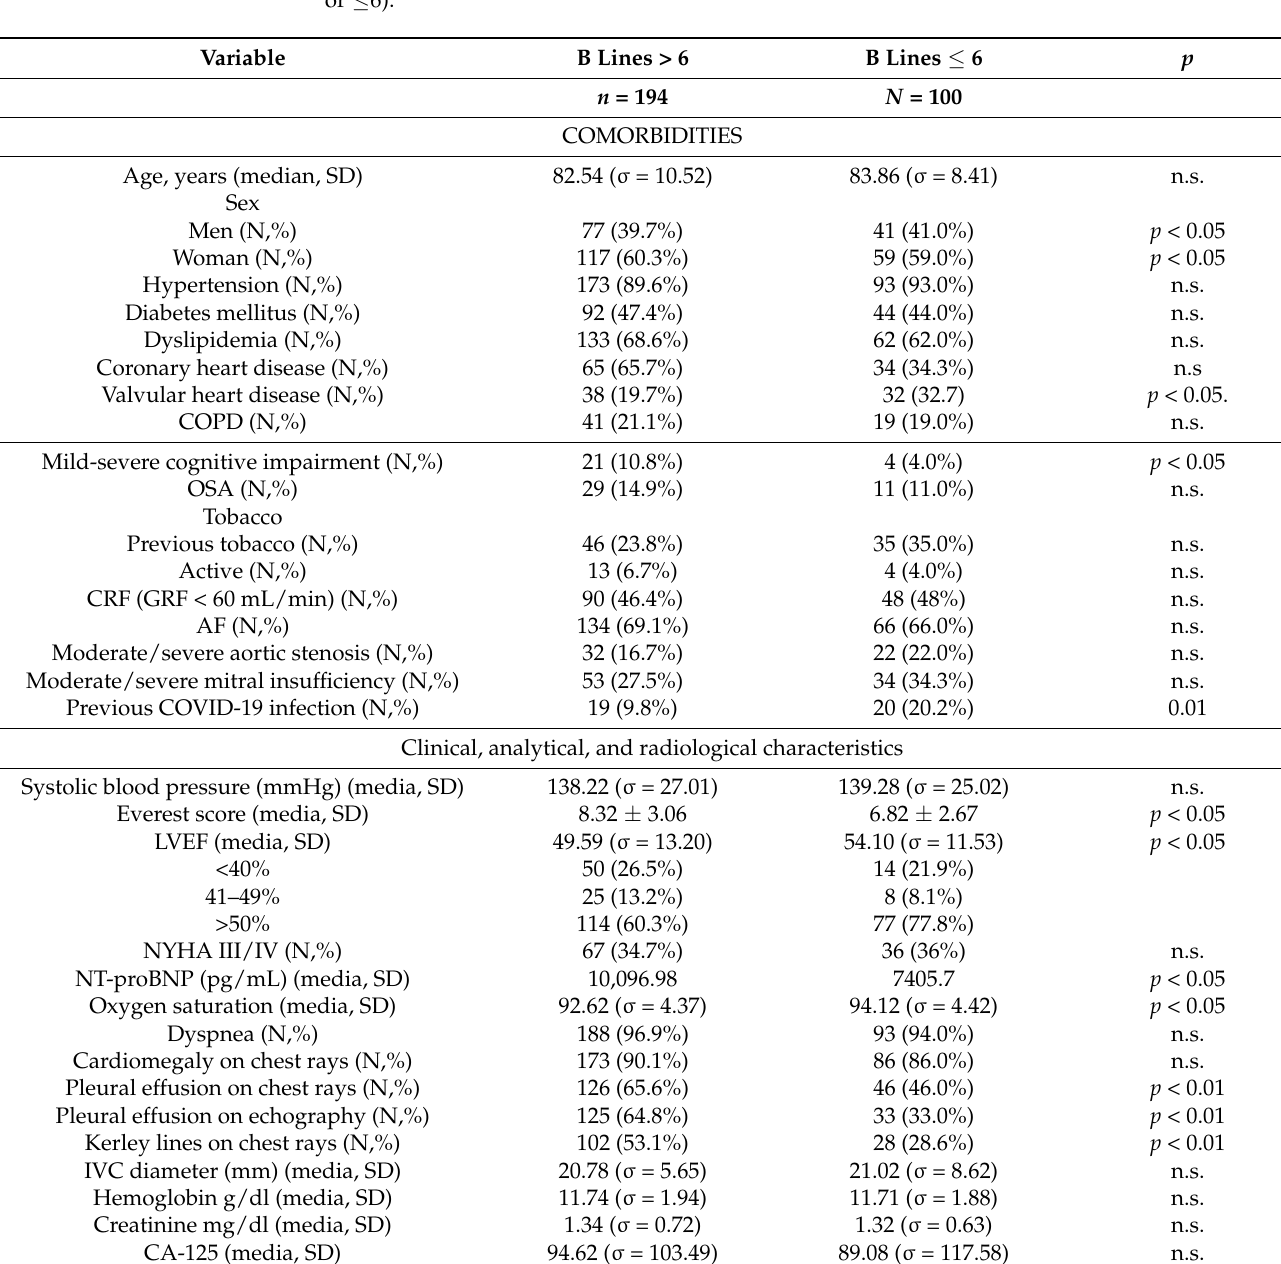
Table 1. Baseline characteristics of patients with heart failure according to the presence of B lines (>6 or ≤